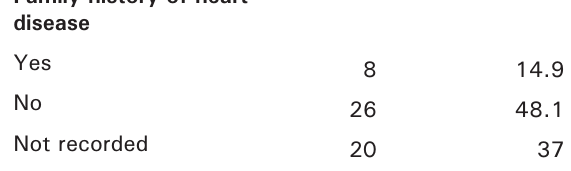
Table 1. Characteristics of patients with Tetralogy of